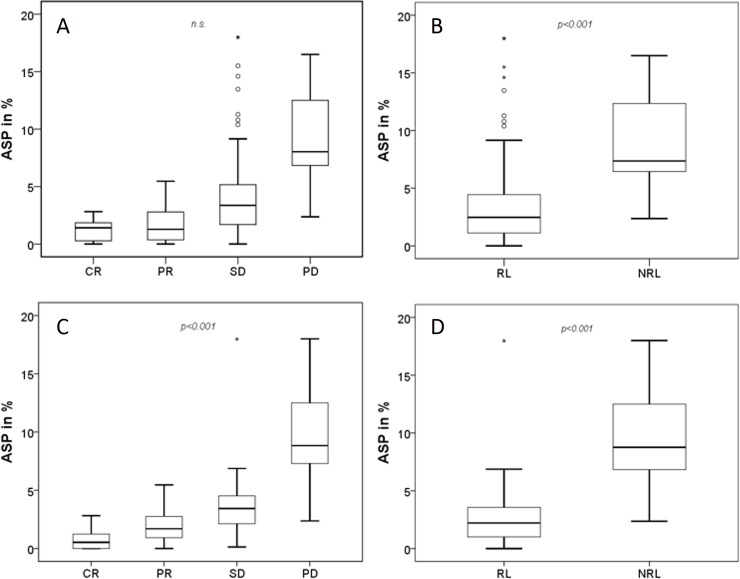
Box plot analysis of ASP.ASP clustered by RECIST criteria after (A) 4 and (C) 12-months follow-up. B and D shows ASP for responding (RL) and non-responding lesions (NRL) for the corresponding follow-up examinations at 4 and 12 months, respectively.